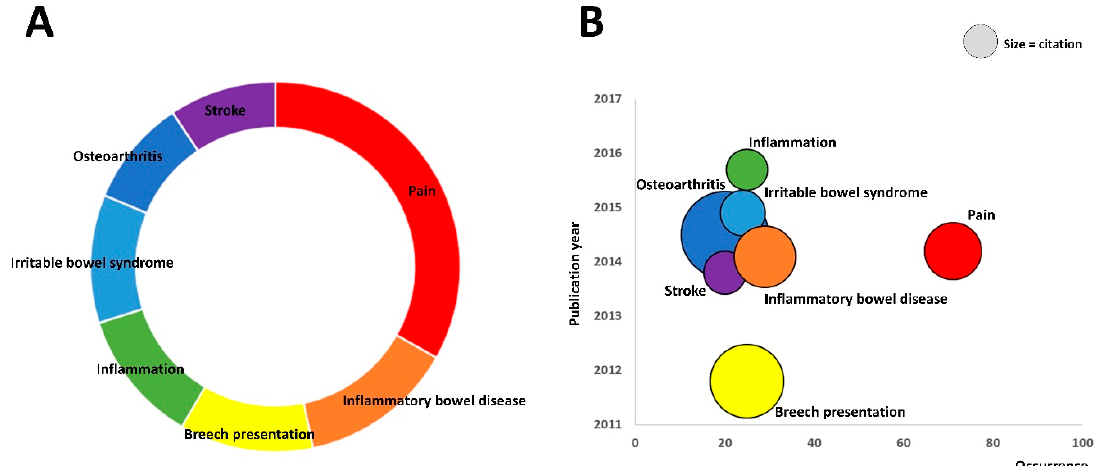
Figure 3. Main diseases using moxibustions using keywords analysis. ( A ) The seven main diseases using moxibustions were found among 40 keywords through keywords analysis: pain (33.2%), inflammatory bowel disease (13.6%), breech presentation (11.7%), inflammation (11.7%), irritable bowel syndrome (11.2%), osteoarthritis (9.3%), and stroke (9.3%). ( B ) When we considered the